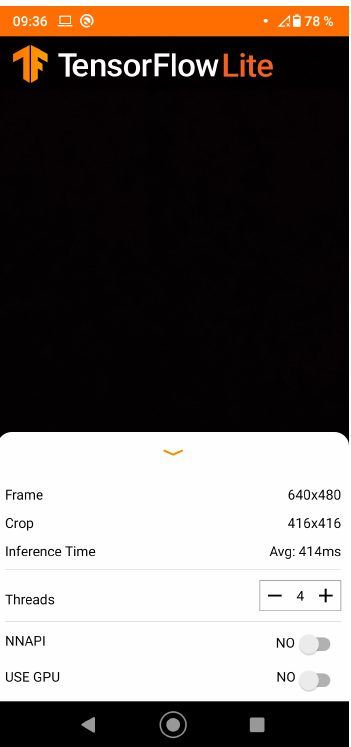
Figure 12. Screenshot of the Tensorflow Lite modified object detection application. The dark area displays the camera input and detections..